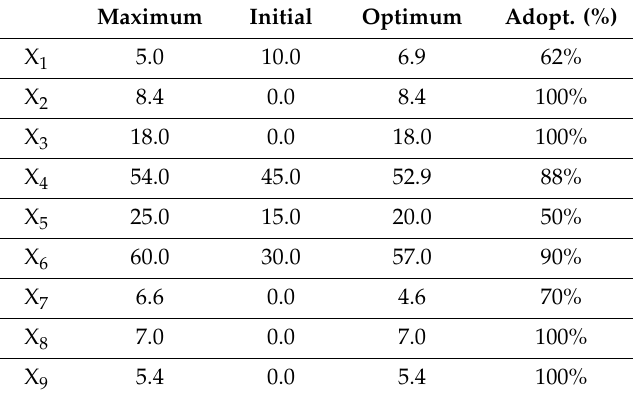
Table 2. Change of design variables (mm).